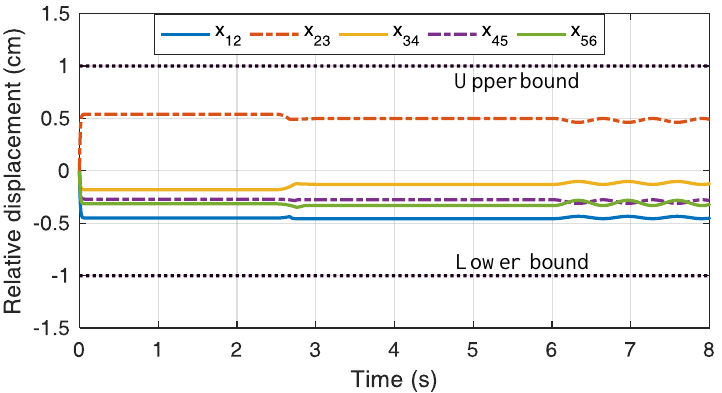
Figure 16. Relative displacement curve of each carriage with the proposed observer-driven consensus braking control strategy in case 3.